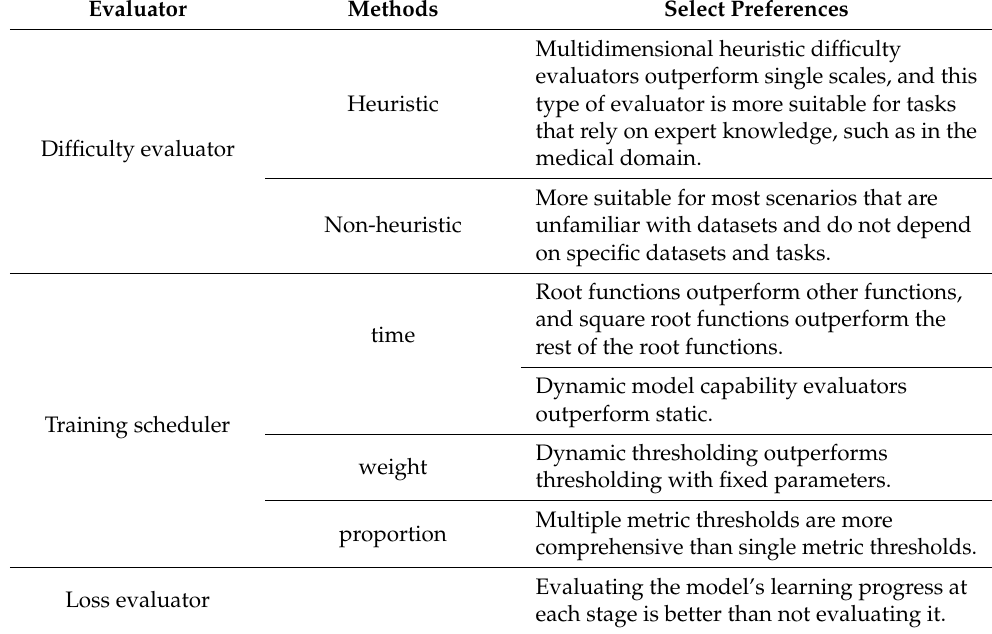
Table 5. Selection recommendations for different